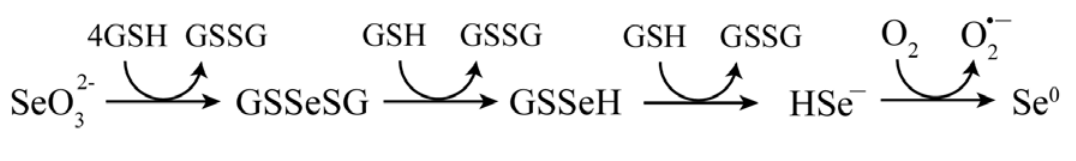
Figure 2. Reaction of selenite with glutathione and subsequent generation of superoxide anion, adapted from